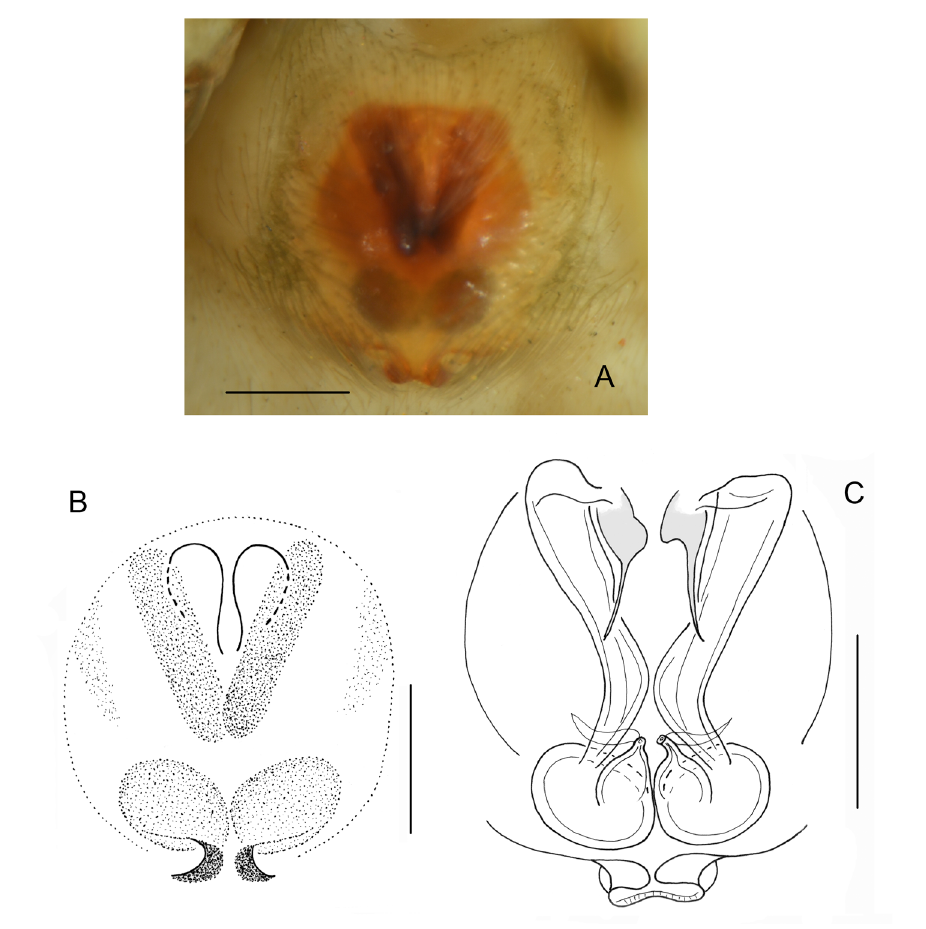
Fig. 12. Pochytoides securis sp. nov., paratypes, ♀. A–B . Epigyne. C . Internal structure of epigyne. scale bars: 0.2